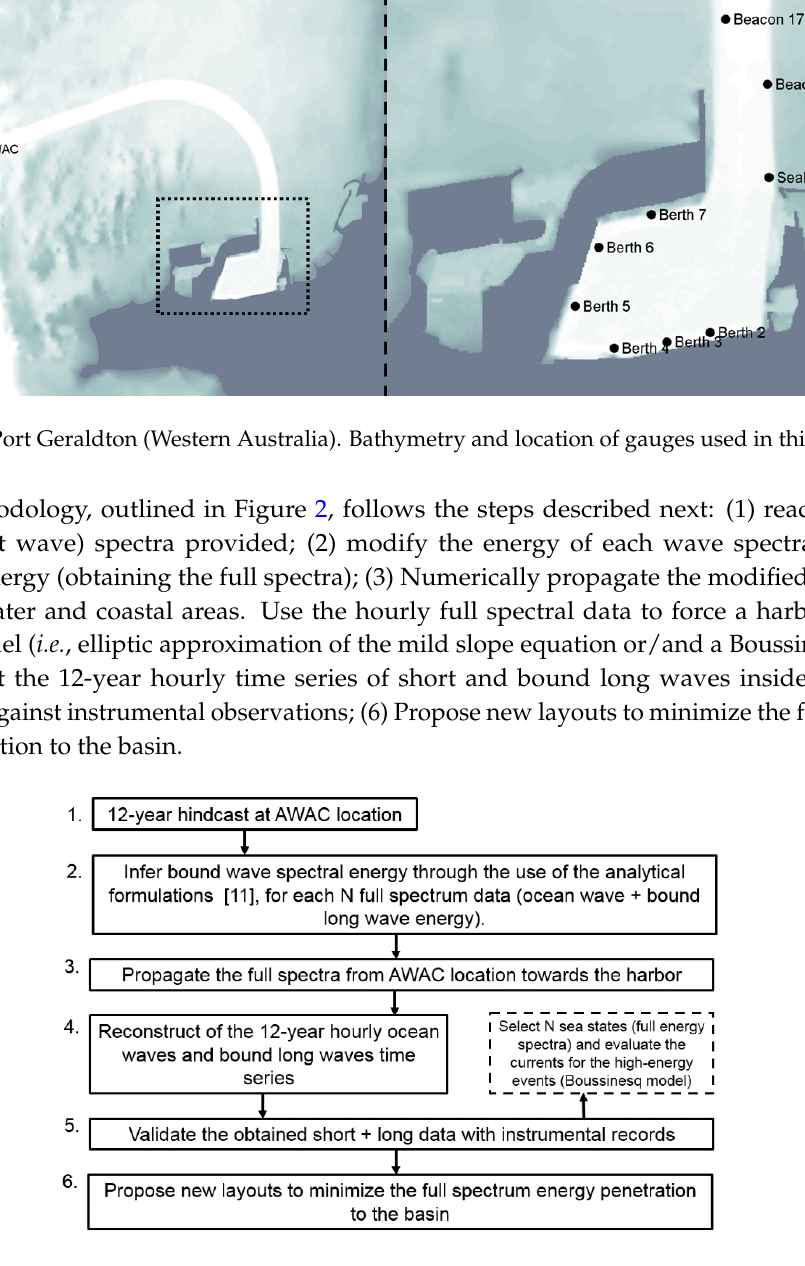
Figure 2. Methodological framework to assess and reconstruct time series for wave + bound long wave spectrum.